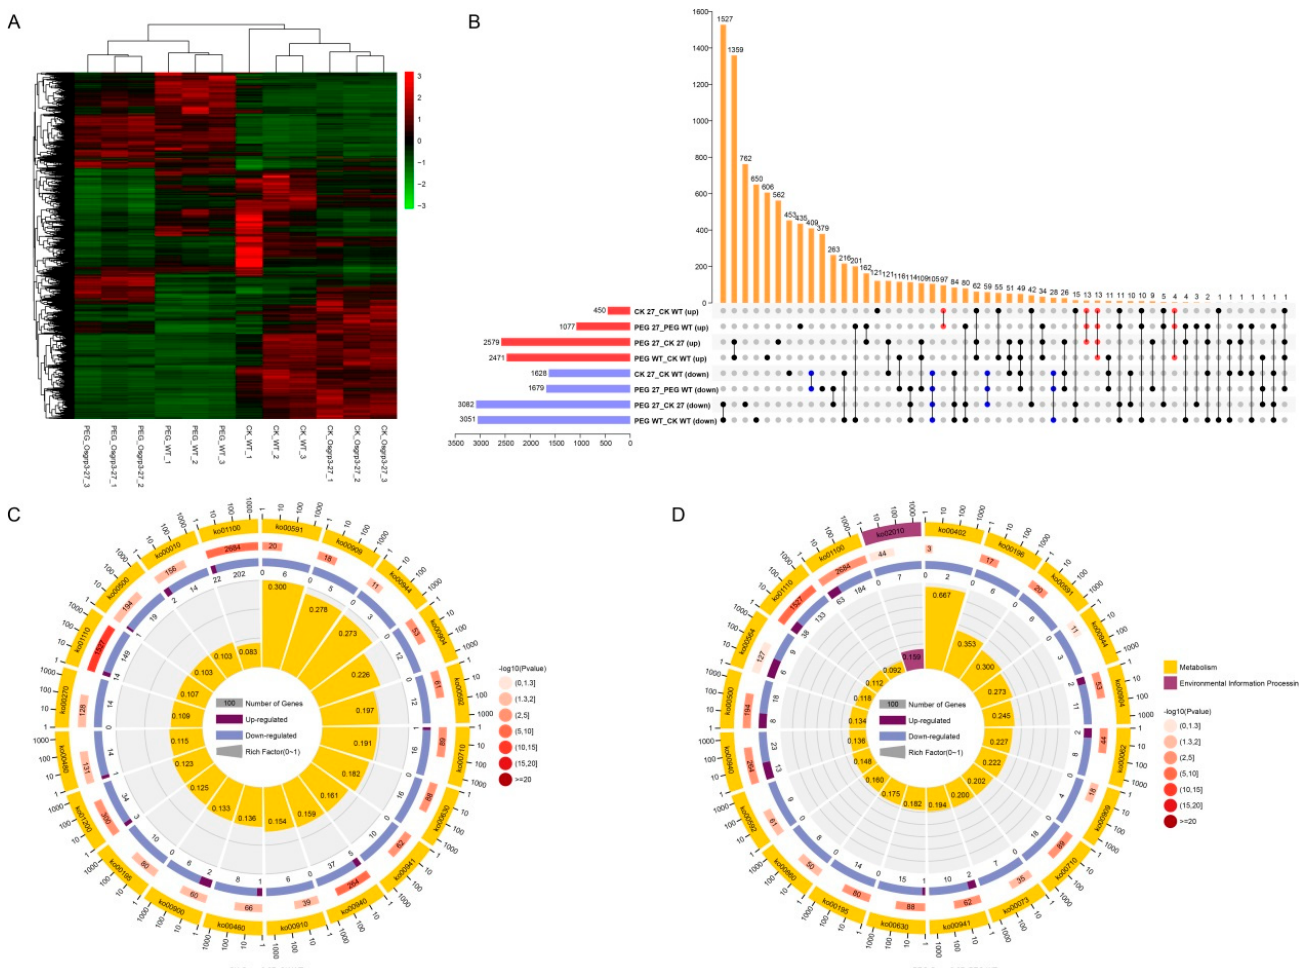
Figure 5. Transcriptome analysis of Osgrp3-27 and WT under control and PEG6000 treatment. ( A ) Cluster analysis of all differentially expressed genes (DEGs). ( B ) Venn plots of DEGs in wild-type ZH11 and Osgrp3-27 under control and 20% PEG6000 treatment. Red represents up-regulated DEGs, and blue represents down-regulated DEGs. Orange represents the intersection of different combinations that solid points refer to. ( C , D ) KEGG analysis of DEGs between Osgrp3-27 and WT under control ( C ) and under PEG6000 treatment ( D ). Numbers on a red background indicate all genes with the corresponding pathway annotation. Numbers on purple and blue backgrounds indicate up-regulated and down-regulated genes separately. The ko number stands for the KEGG pathway.